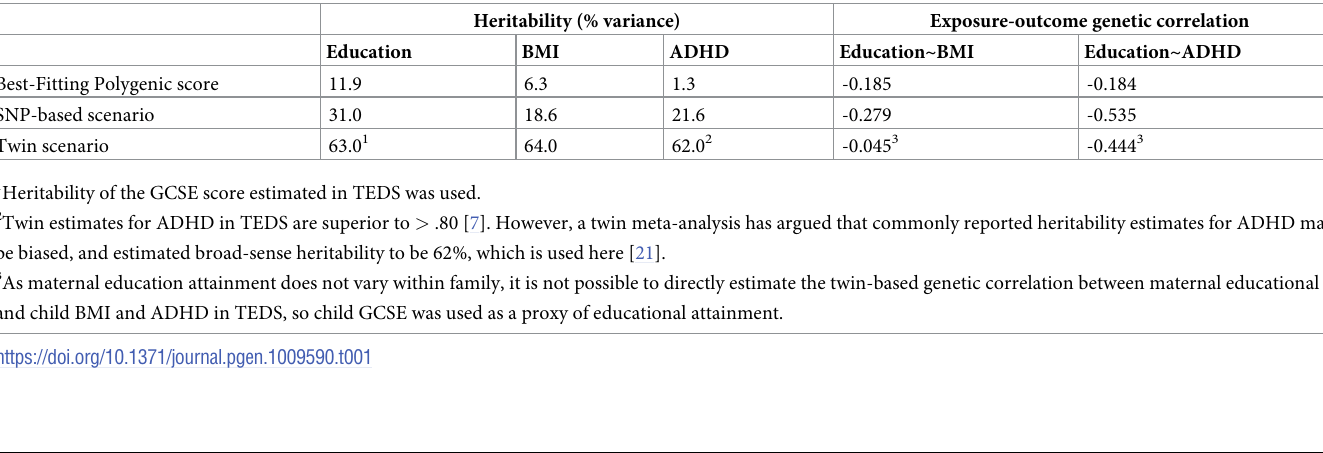
Table 1. Heritability and genetic correlation under different